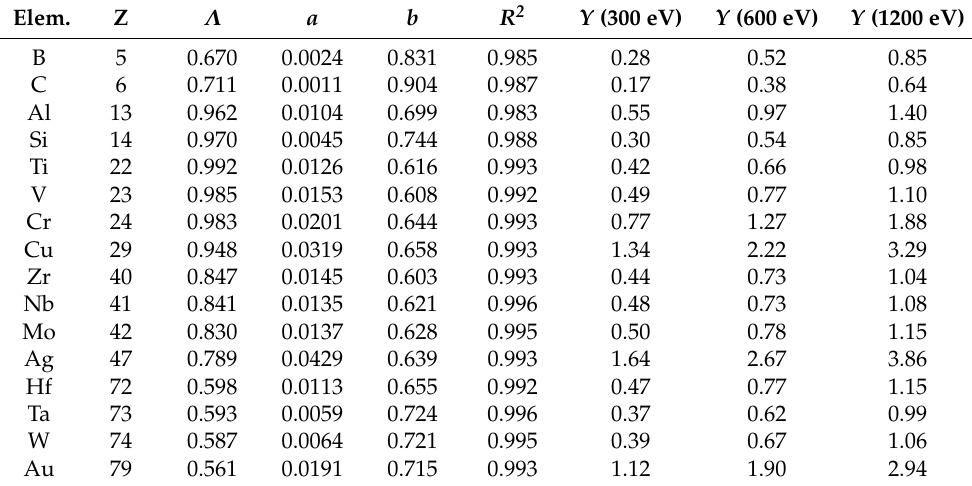
Table 2. Fitting parameters for the sputtering yield ( a and b ) and the coefficient of determination R 2 together with the atomic number Z, the energy transfer factor Λ , and the simulated sputtering yields at three different energies. Elem.